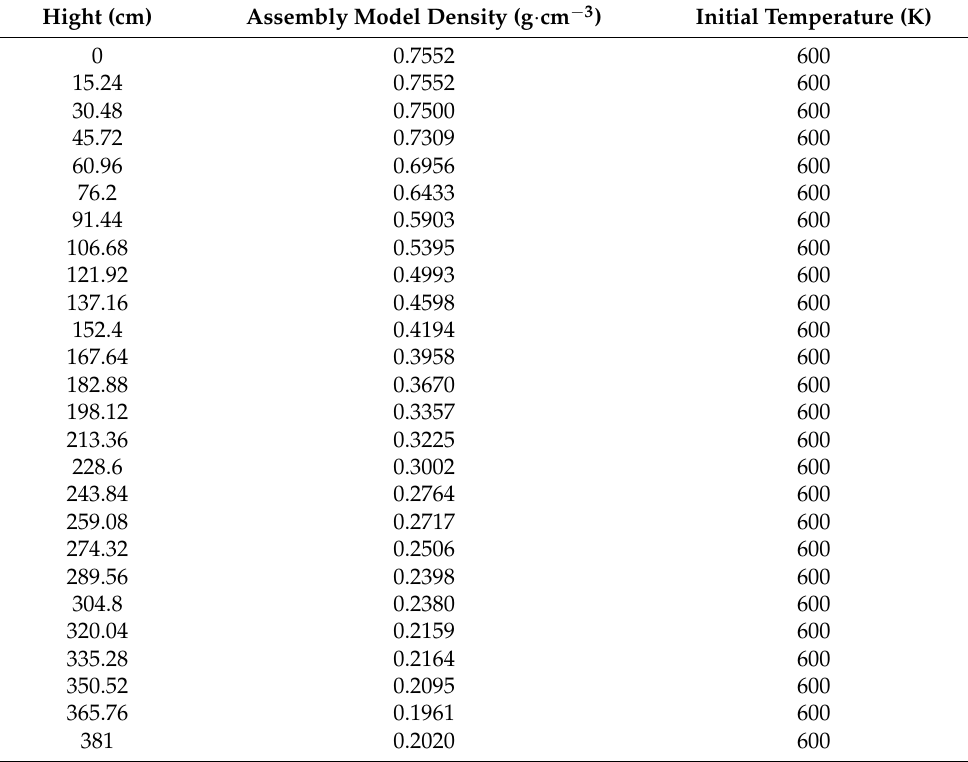
Table A2. Serpent’s initial coolant channel data.